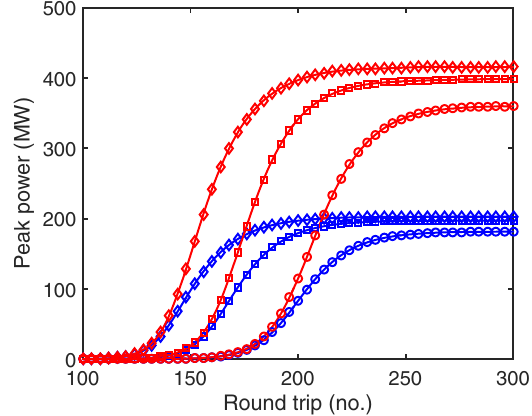
FIG. 3. The growths of output peak power in FEL oscillators from steady-state simulations, in which the blues are results from a normal oscillator with 25% single-pass gain from a single-stage undulator, while the reds are results from an FEL oscillator with 25% single-pass gain from two-stage cascaded undulator, i.e., 12% from each one. The diamond, square and circle represent the cases with the output coupling efficiency of 6%, 8% and 10%, respectively, and the passive loss of the cavity is assumed to be